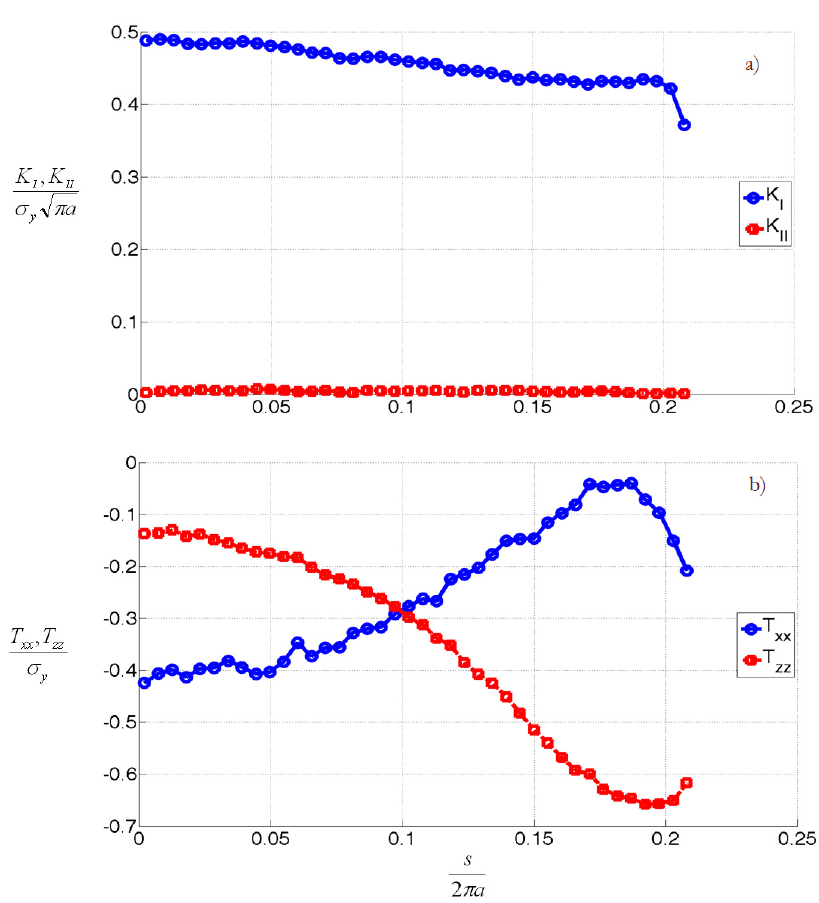
Figure 3: The distribution of the stress intensity factors (a) and the non-singular stresses (b) along the crack front.